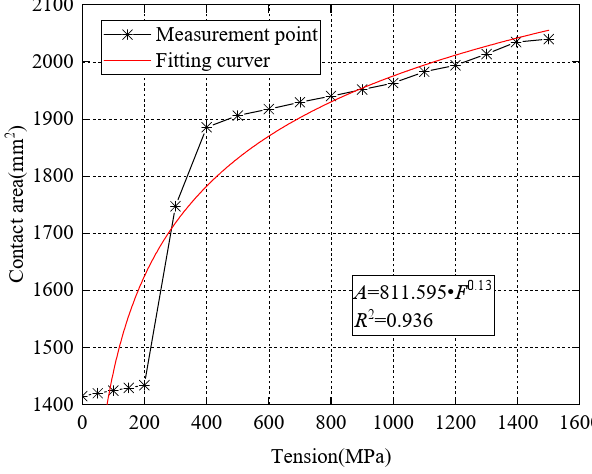
Figure 10. Contact area between barrel and wedges.